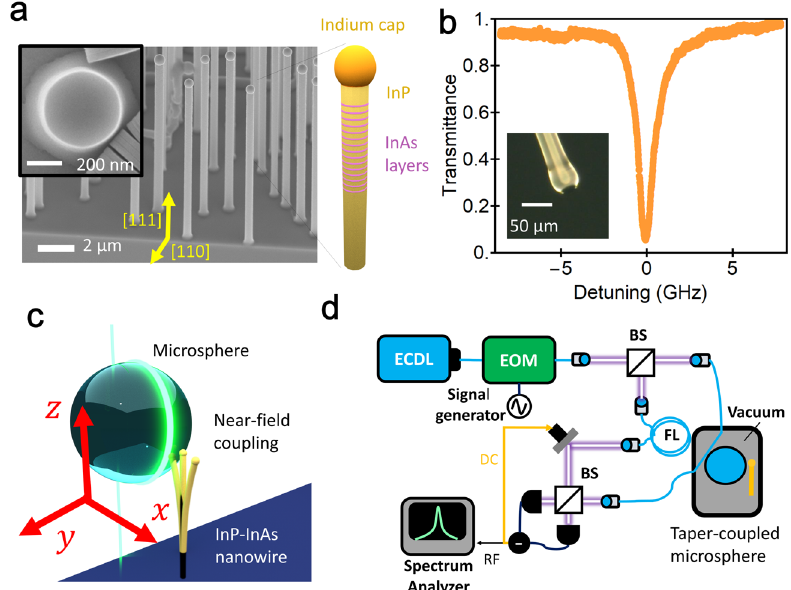
Fig. 2 Device and setup for near- fi eld cavity optomechanics. a Scanning microscope image of as-grown InP/InAs heterostructured nanowires and a schematic of the internal structure of a nanowire. The crystal orientation for the growth direction [111] and direction of cleaved surface [110] are represented by yellow vectors. The inset shows a cross-sectional image of a nanowire. b Transmission spectrum of the optical cavity with a microscope image of it (inset). c Illustration of the con fi guration of the microsphere and nanowire with coordinates de fi ned such that the radial direction of the whispering-gallery mode corresponds to the x -axis. d Schematic of optical measurement setup with a fi ber-based balanced homodyne interferometer. ECDL external cavity diode laser, EOM electro-optic modulator, BS beam splitter, FL fi ber